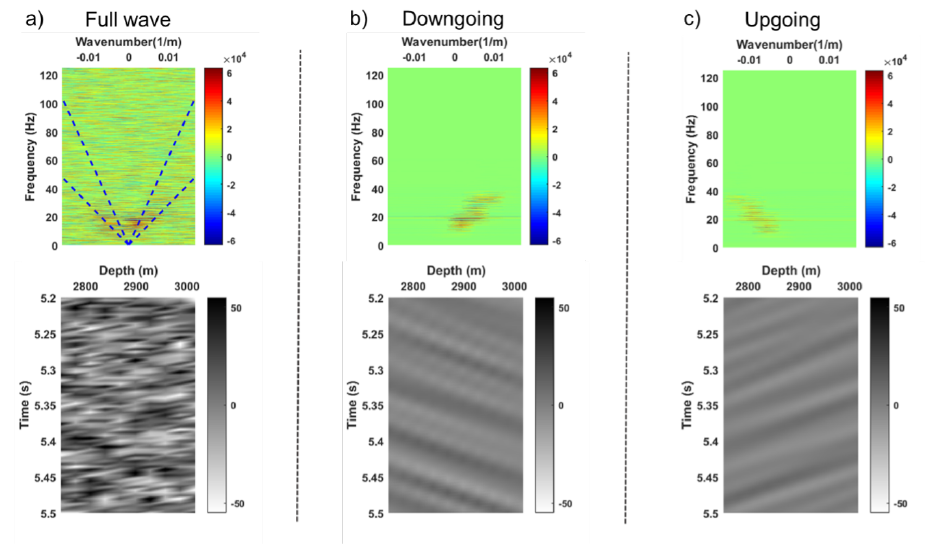
Figure 14. Wavefield separation of noise data in the f - k domain. ( a ) The up- and downgoing wavefield and its f - k spectrum. ( b ) The downgoing wavefield and its f - k spectrum. ( c ) The upgoing wavefield and its f - k